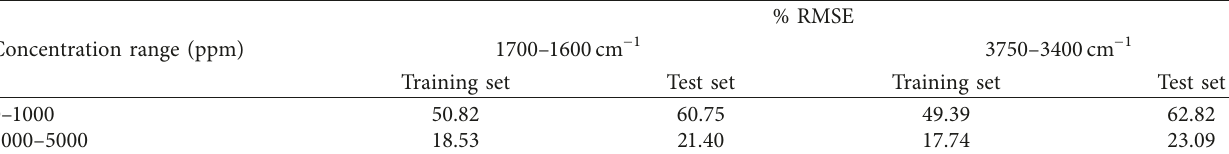
Table 5: Average % RMSE for subsets of low and high moisture concentrations in transformer oil according to spectral regions at 3750–3400 and 1700–1600cm − 1 .